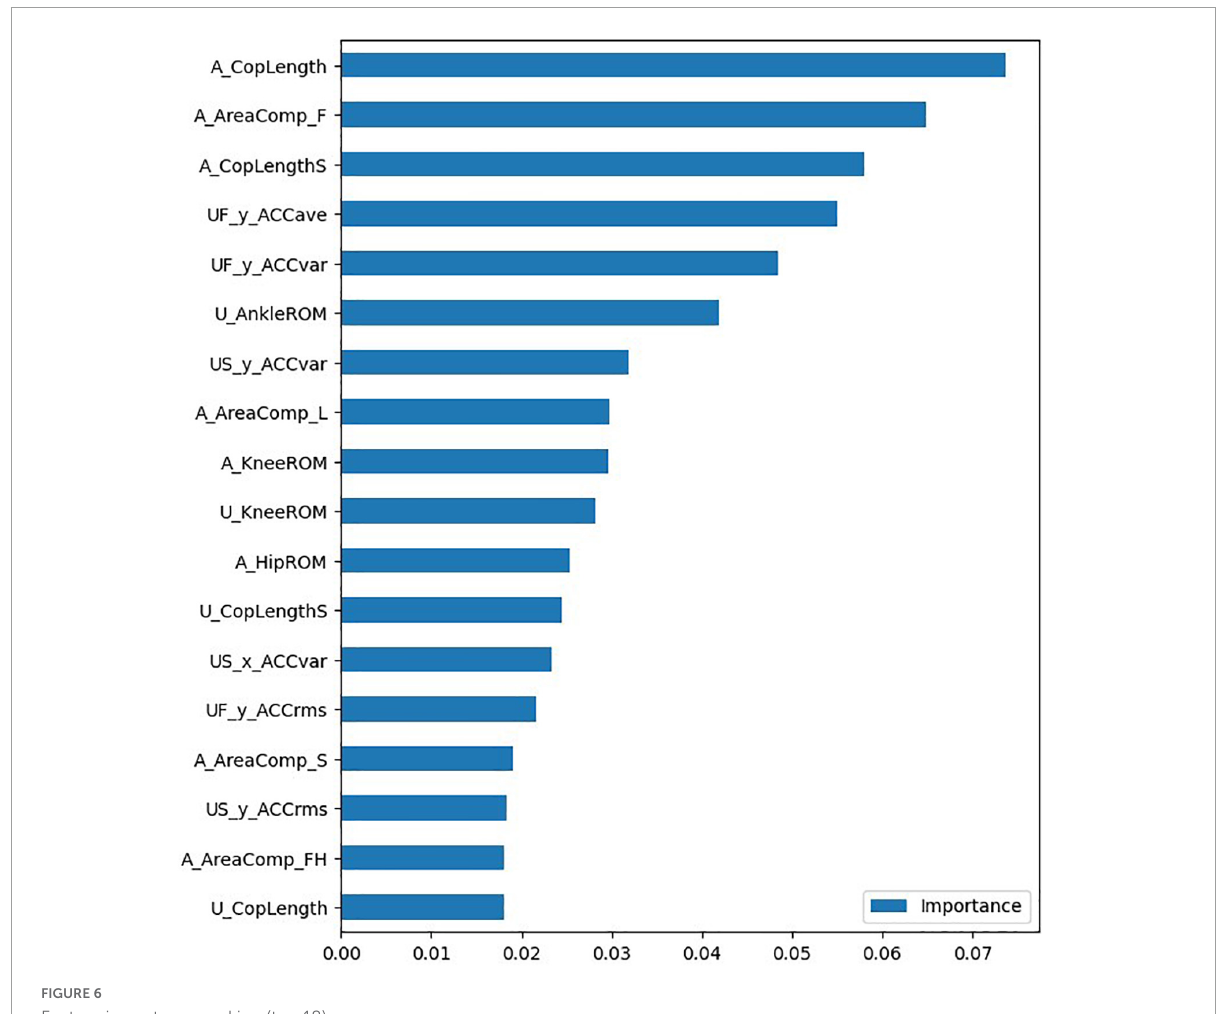
FIGURE6 Feature importance ranking (top 18).